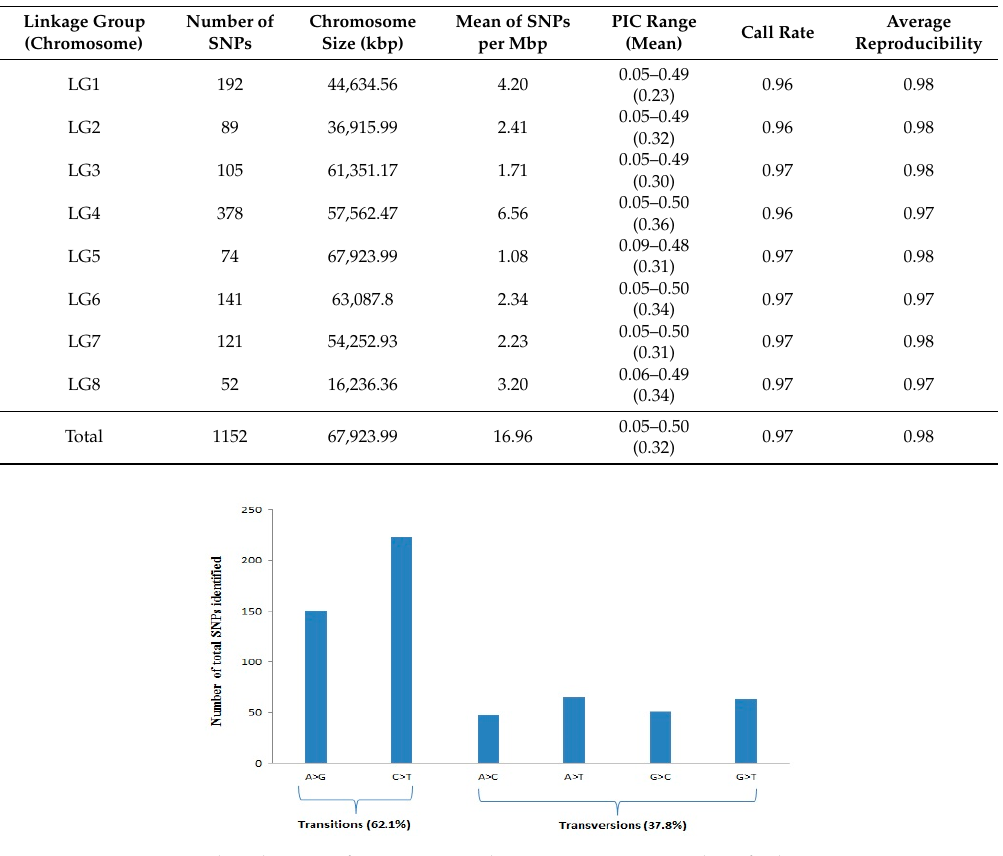
Table 1. Polymorphism information content (PIC), call rate, average reproducibility, and distribution of DArTseq-SNPs on chickpea chromosomes.